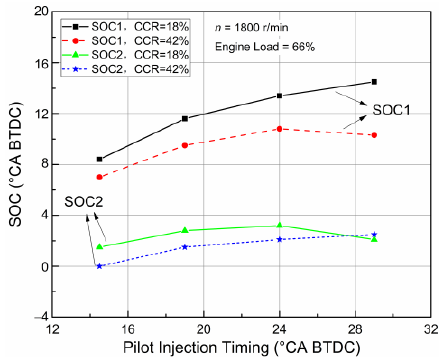
Figure 5. SOC1 and SOC2 under different pilot injection timings.